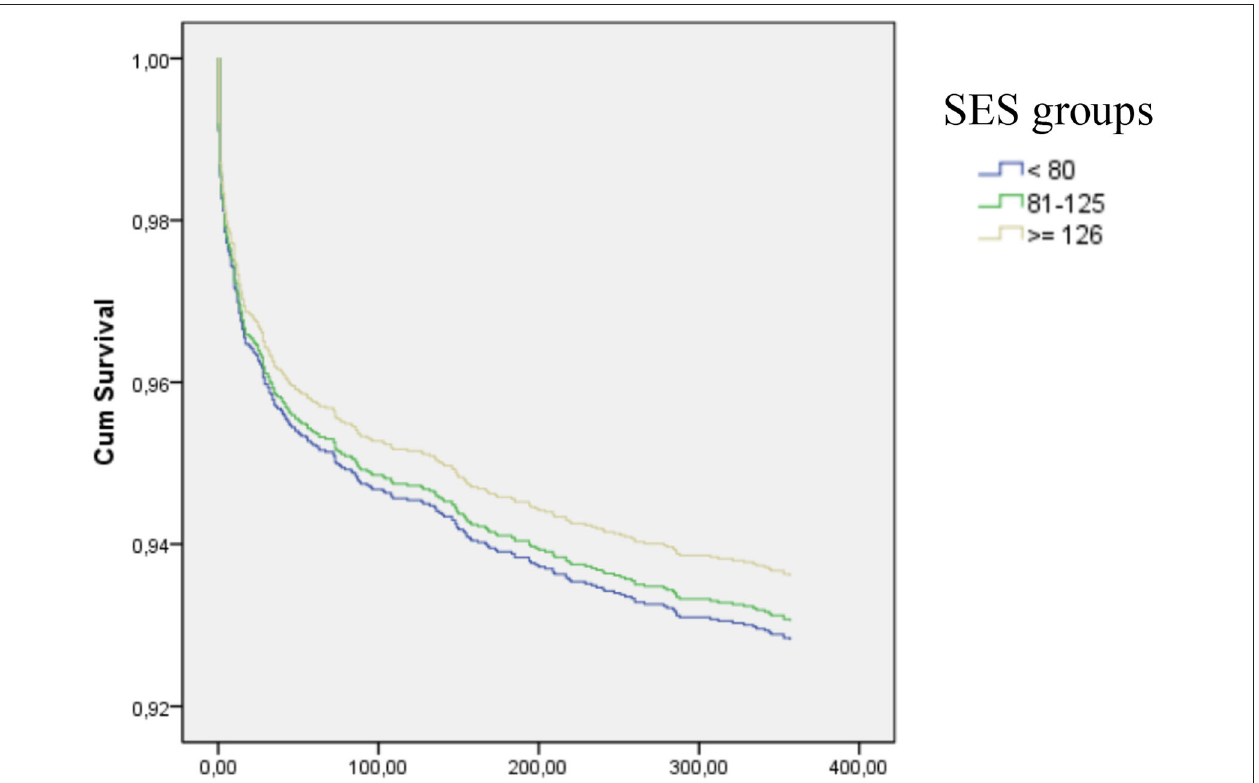
networks for the early management of high-impact diseases in terms of incidence, hospitalization, and case fatality such as in STEMI (23,